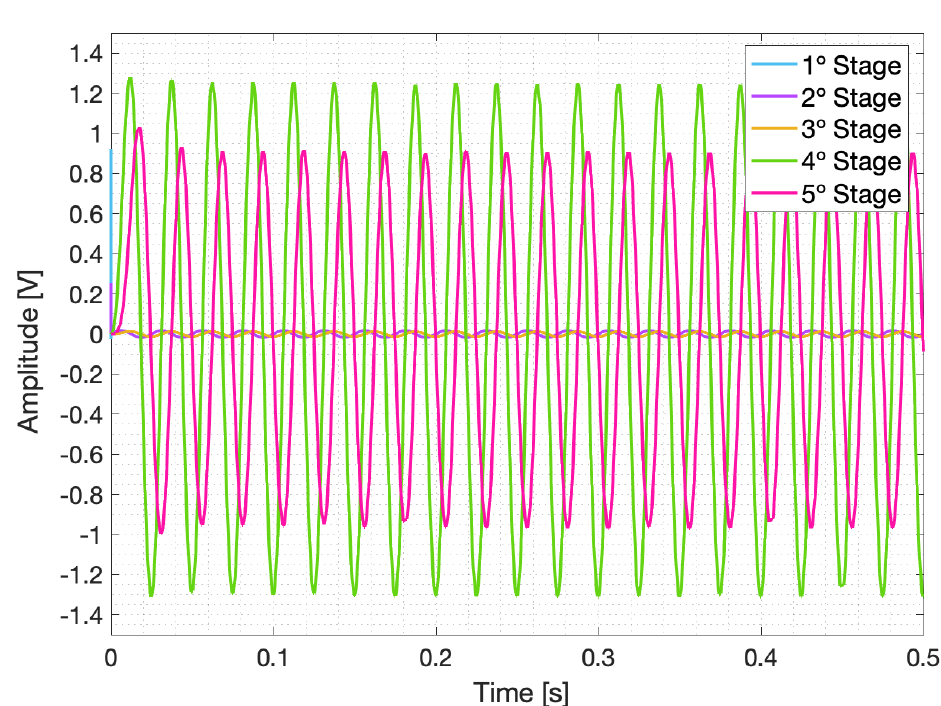
Figure 11. Graphs of each conditioning circuit 1 stage when f = 40 Hz.